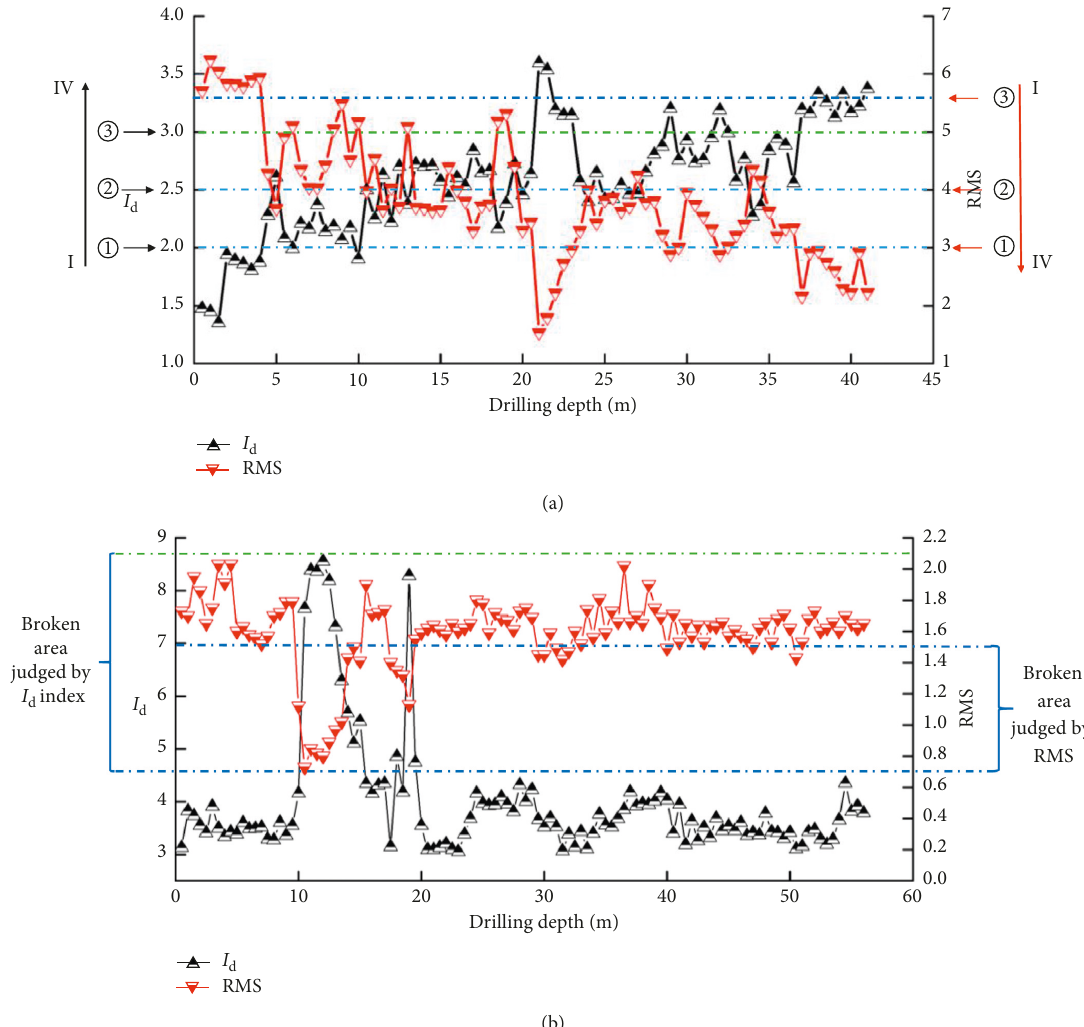
Figure 20: Comparison of the results of MWD and VMWD systems. (a) Cross-layer borehole No. 12. (b) In-seam borehole No. 22. Table 5: Rock mass classification results of MWD and VMWD systems of cross-layer borehole No. 12. Rock classification